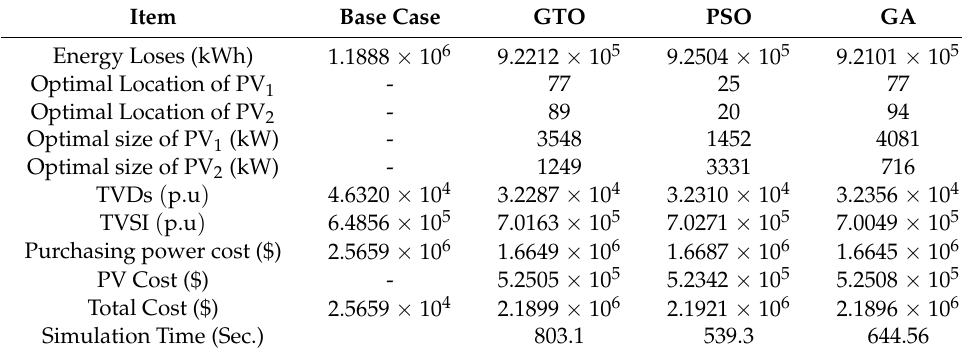
Figure 7. The output power from the second unit for case 1. Table 2. The simulation results for case